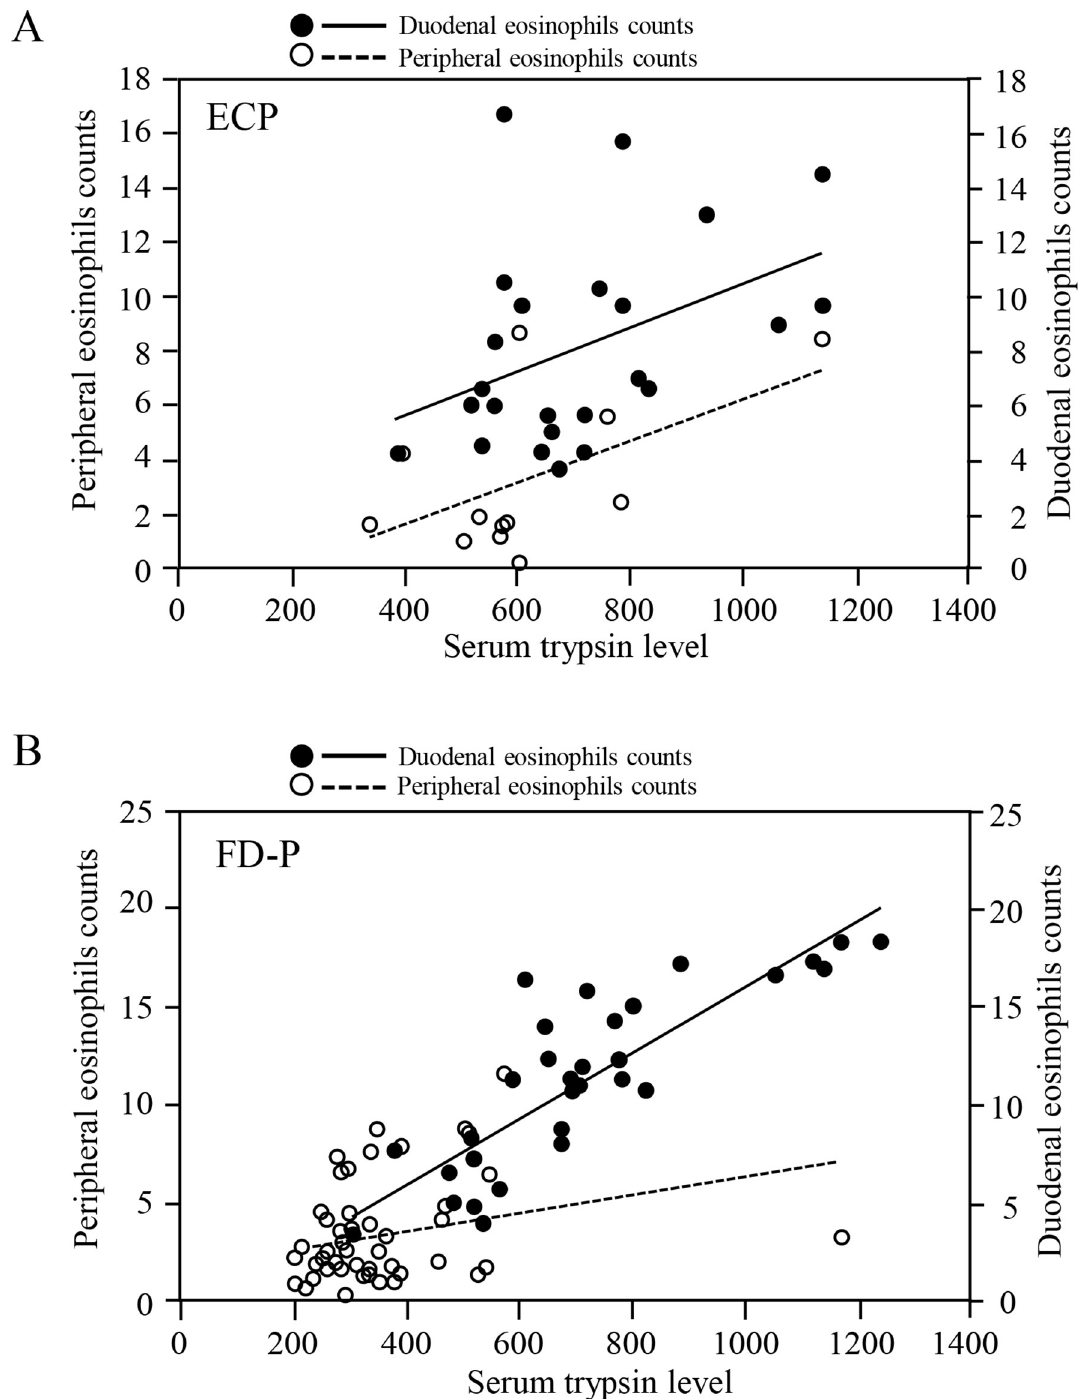
Fig 5. Trypsin levels were associated with peripheral and duodenal eosinophils counts in ECP and FD-P patients. Serum trypsin levels were significantly (p = 0.007, R 2 = 0.549) associated with peripheral eosinophils counts in patients with ECP (Fig 5A). In addition, serum trypsin level was not significantly (p = 0.05, R 2 = 0.267) associated with peripheral eosinophils counts in FD-P patients (Fig 5B). In addition, serum trypsin levels in ECP and FD-P patients were also significantly (p < 0.05, R 2 = 0.419 and p < 0.001, R 2 = 0.838, respectively) correlated with duodenal eosinophils counts (Fig 5A and 5B). These groups were compared using a correlation coefficient.